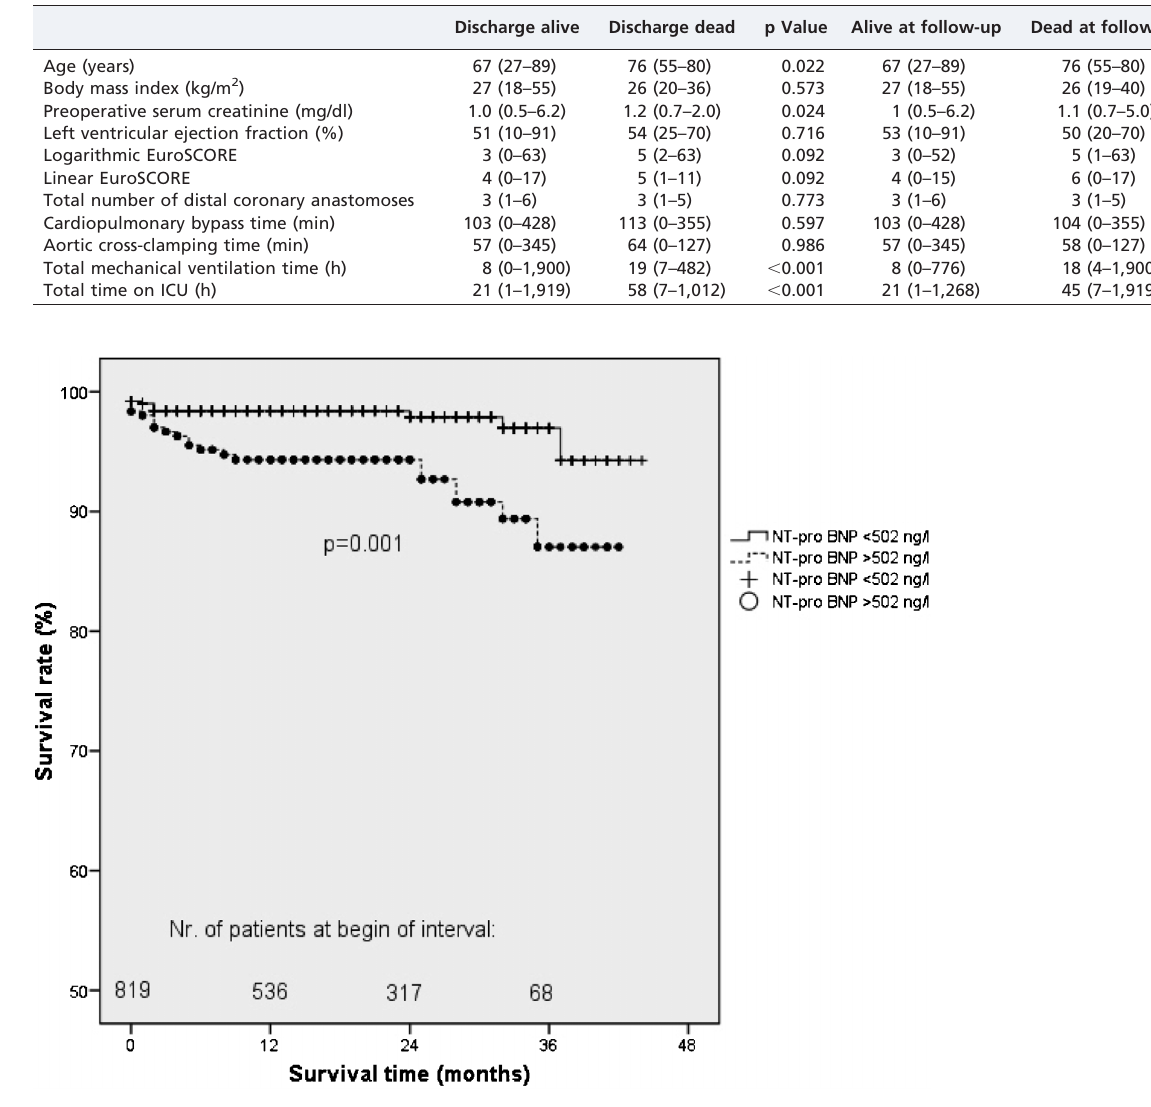
Figure 2 - Survival rate of coronary artery bypass patients with preoperative serum N-terminal pro-brain type natriuretic peptide (NT- proBNP) levels . 502 ng/l compared with NT-proBNP levels , 502 ng/l.